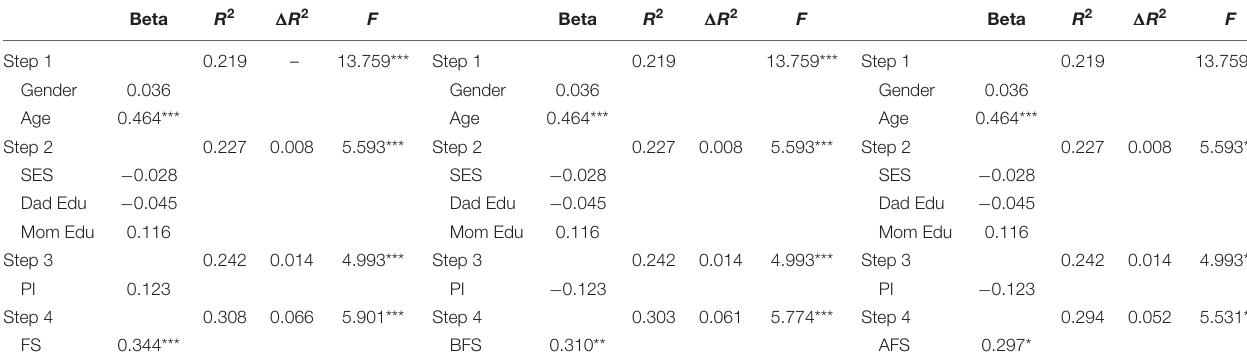
TABLE 5 | Summary of hierarchical regressions predicting spatial ability (map-use).